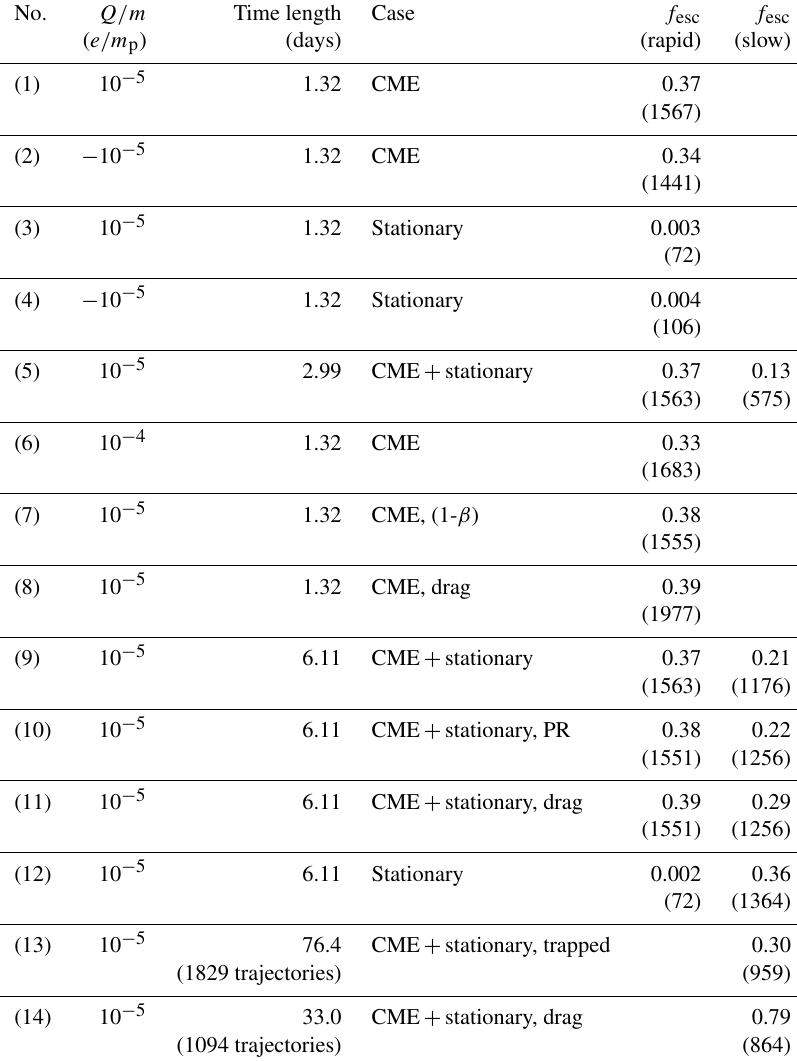
Table 1. Escape fractions f esc for rapidly and slowly escaping populations.